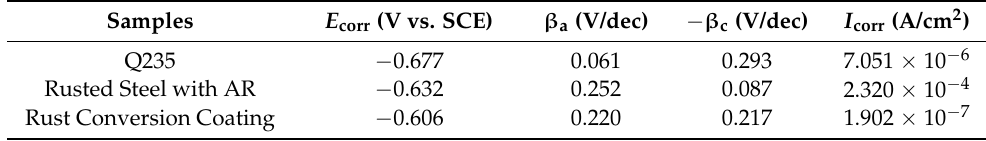
Figure 4. Tafel polarization curves of samples before and after rust conversion treatment. Table 4. Corrosion parameters calculated from Tafel polarization curves measured in Figure 4.